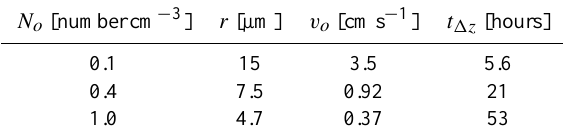
Table 1. Estimates of effective ice crystal radius ( r ), subsequent fall speeds ( v o ), and the time required to fall through the thickness of the cloud t 1z . Calculations are made for three different number concentrations ( N o ) and assume a cloud thickness ( 1z ) of 700m.